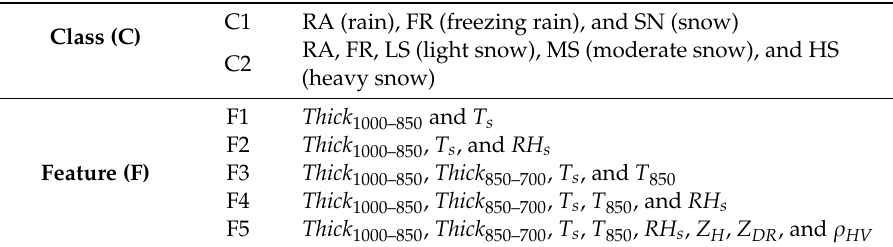
Table 2. Model target classes and input features for various model configurations.